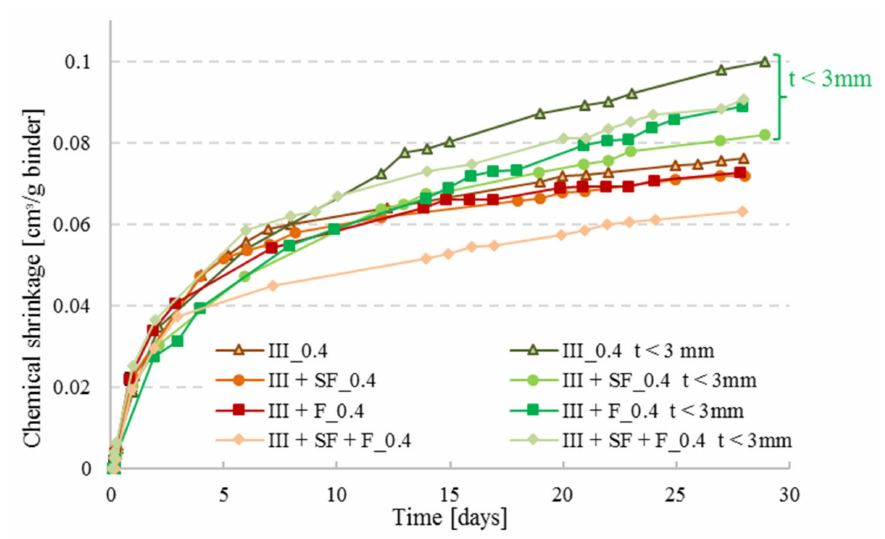
Figure 8. CS measurements of pastes with CEM III combined with silica fume (SF) and/or filler (F) at w/c = 0.4. Two sets were tested: one set at a thickness required by ASTM C1608 (t = 5 mm) and one set with thickness t < 3 mm.